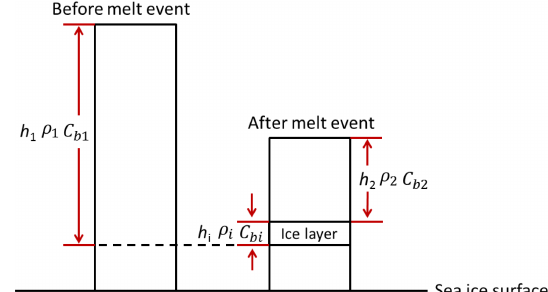
Figure 3. Conceptual sketch of snow overlying sea ice before and after the melt event. Variables relating to the snow and ice layer mentioned in Eqs. (1) and (2) are